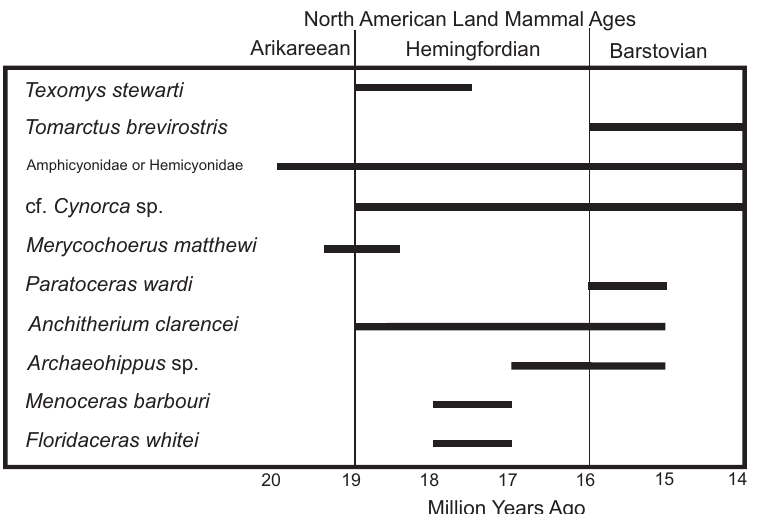
Figure 8. Biostratigraphy of the ten taxa of land mammals found in the Gaillard Cut Local Fauna in the Culebra and Cucaracha formations, Panama, based on the North American Land Mammal Age of their conspecific taxa in North America.